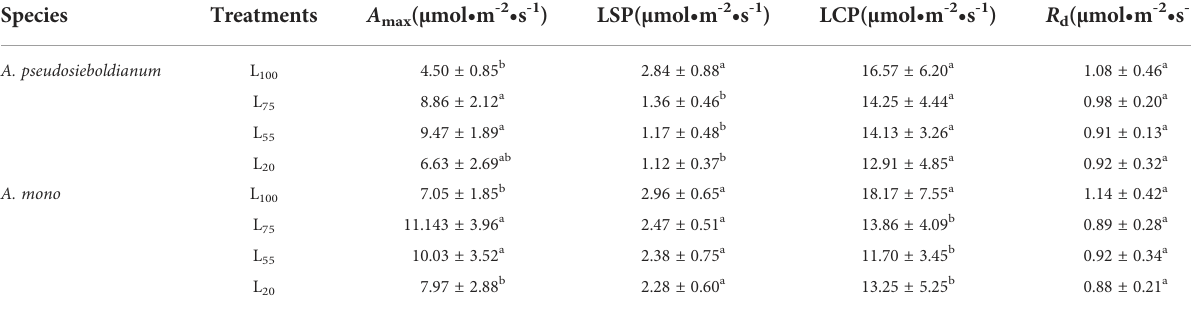
TABLE 1 Photosynthetic characteristics of two maple seedlings under different light intensity treatments. Species Treatments